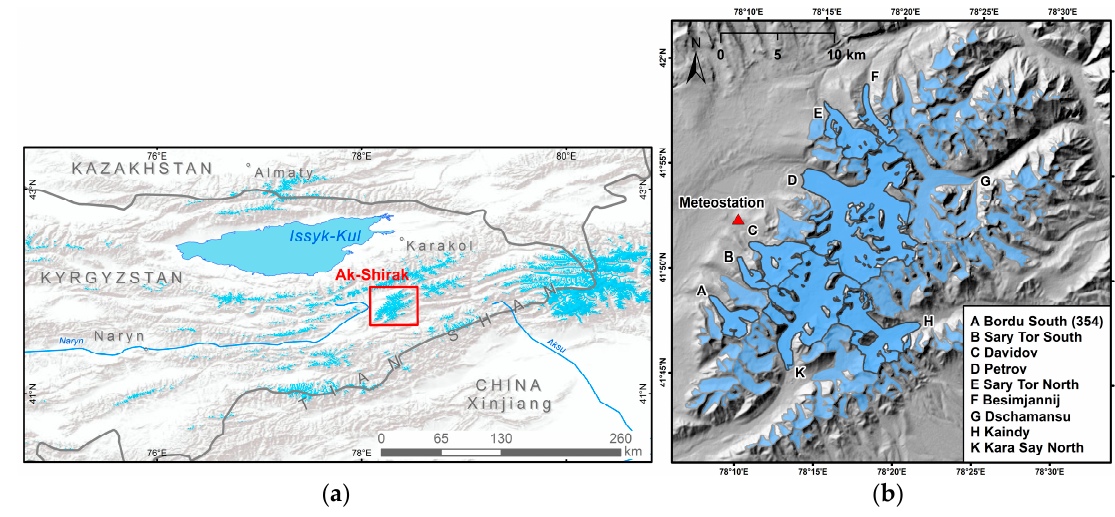
Figure 1. Location of the study area within the Tian Shan ( a ); the glacierised Ak-Shirak massif showing the 1964 glacier extent. Investigated single glaciers are labelled with capital letters ( b ).